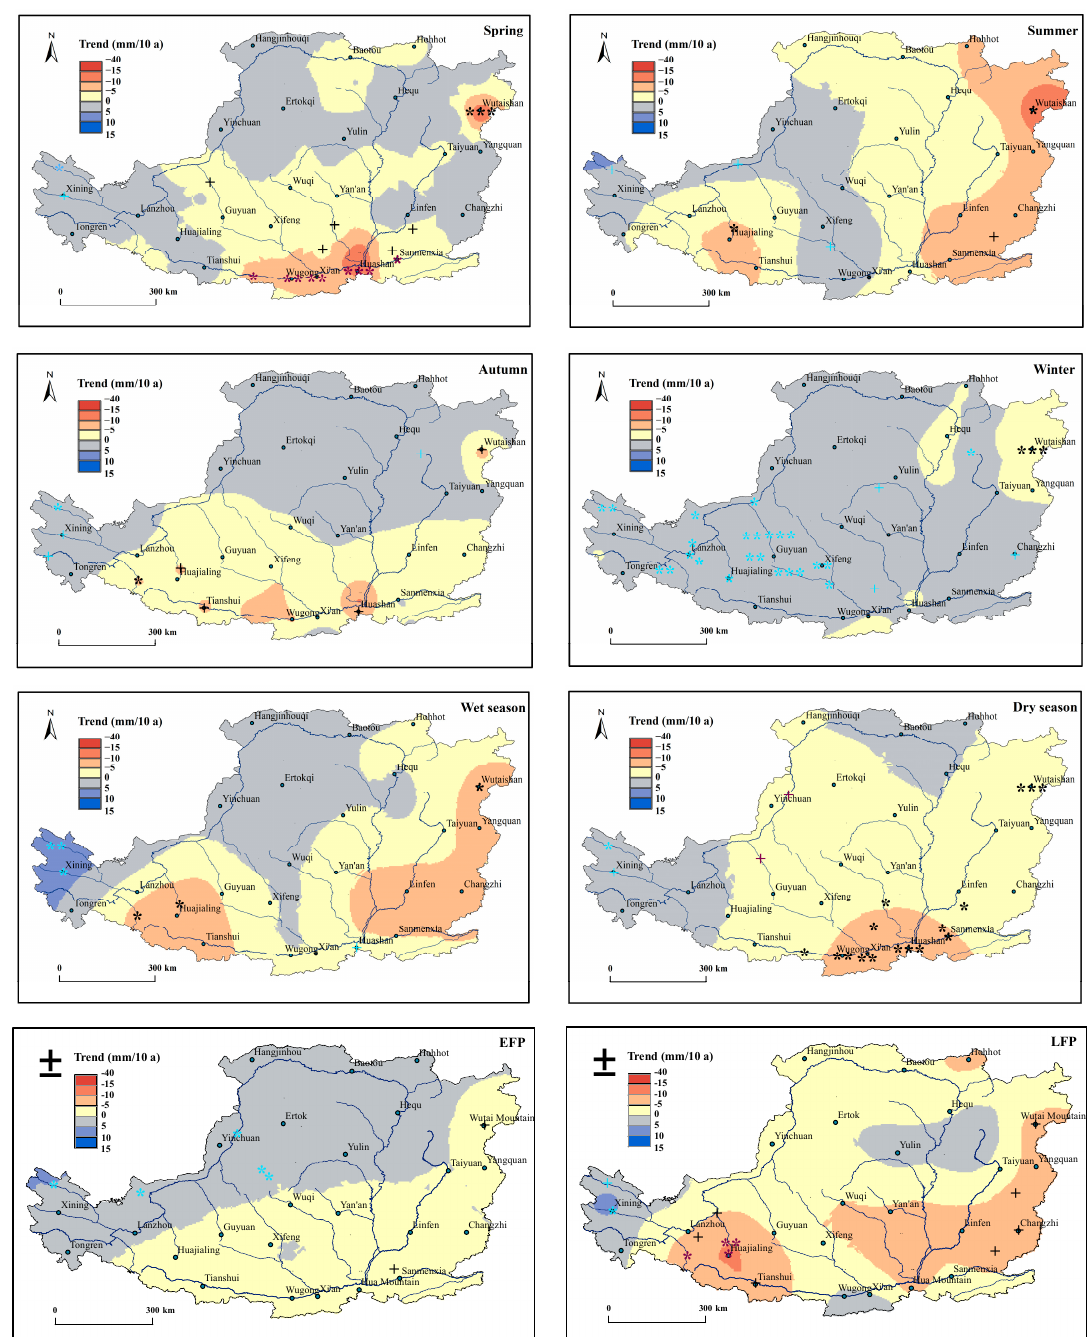
Figure 3. Spatial trends in precipitation for the eight sub-annual periods, namely spring, summer, autumn, winter, wet season, dry season, EFP and LFP. The blue symbols represent increasing trend and the red represent decreasing trend. The symbols of +, *, **, *** mean passing the significance level of 0.1, 0.05, 0.01, and 0.001, respectively. The symbols of ***** represents the significance of the two adjacent Table 3. The mean annual change trend of seasonal rainfall (mm/a) over the Loess Plateau, China. Spring Summer Autumn Winter Wet Season Dry Season EFP LEP